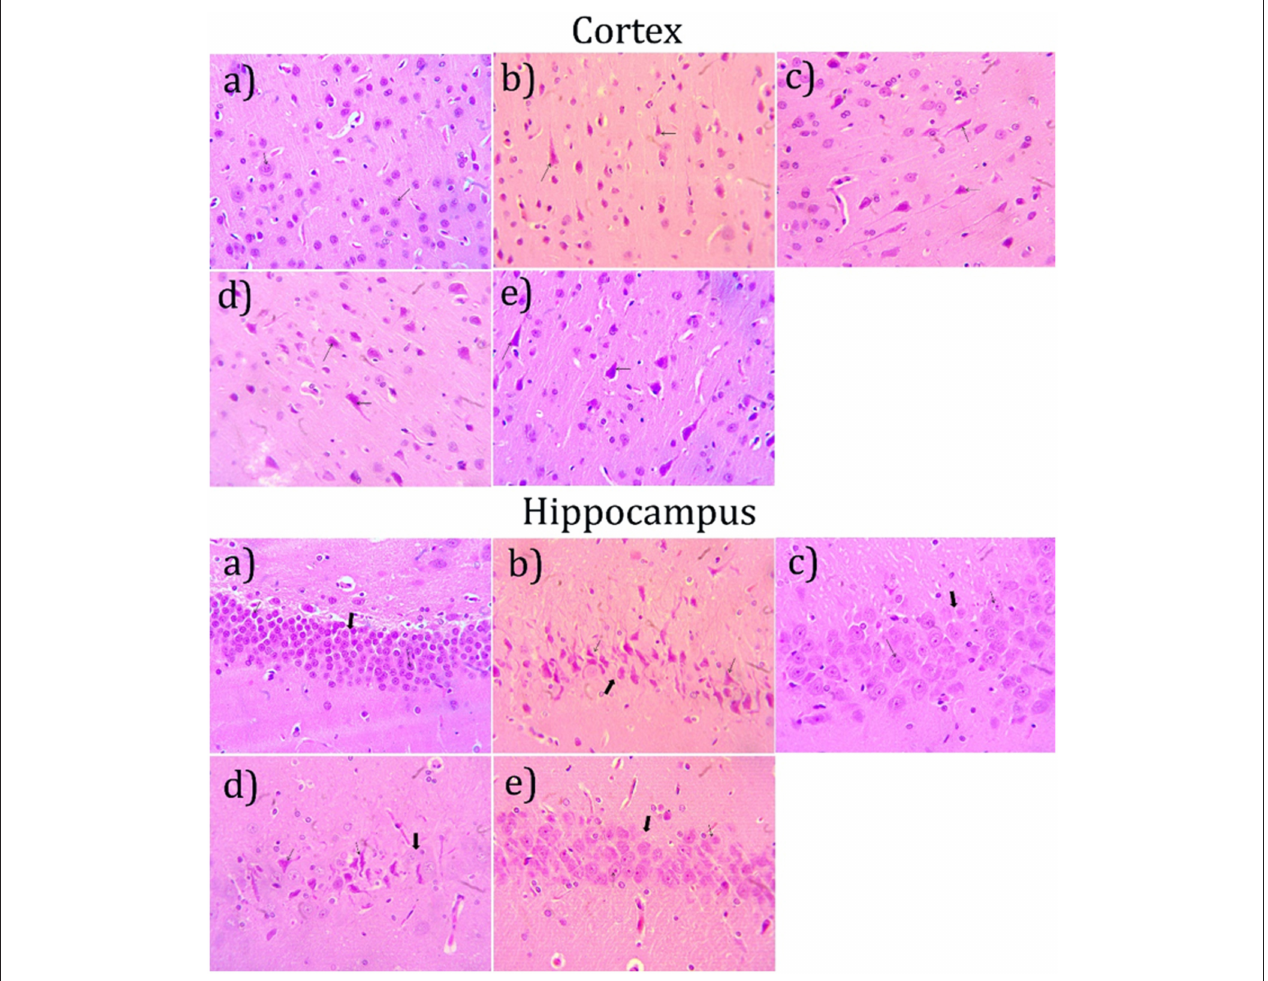
FIGURE 6 | Effect of Cardamom oil on H.E. stained hippocampus and cortex tissue (400X). (a) Normal control group: Hippocampus and Cortex: showing normal histology, normal neuronal cell (small arrow) {H & E, 400X}, (b) AlCl 3 group: Hippocampus and Cortex: showing neuronal degeneration with pyknotic nuclei (small arrow), reduced layer of neuronal cell (Large arrow) {H & E, 400X}. (c) AlCl 3 + Donepezil hydrochloride (1 mg/kg): Hippocampus and Cortex: showing normal histology, focal mild neuronal cell with pyknotic nuclei (small arrow) {H & E, 400X}, (d) AlCl 3 + Cardamom oil (100 mg/kg): Hippocampus and Cortex: showing neuronal degeneration with pyknotic nuclei (small arrow), reduced layer of neuronal cell (Large arrow) {H & E, 400X}. (e) AlCl 3 + Cardamom oil (200 mg/kg): Hippocampus and Cortex: showing focal mild neuronal cell with pyknotic nuclei (small arrow) {H & E, 400X}. The magnification was 400X. H.E., Hematoxylin and eosin; AlCl 3 , Aluminum